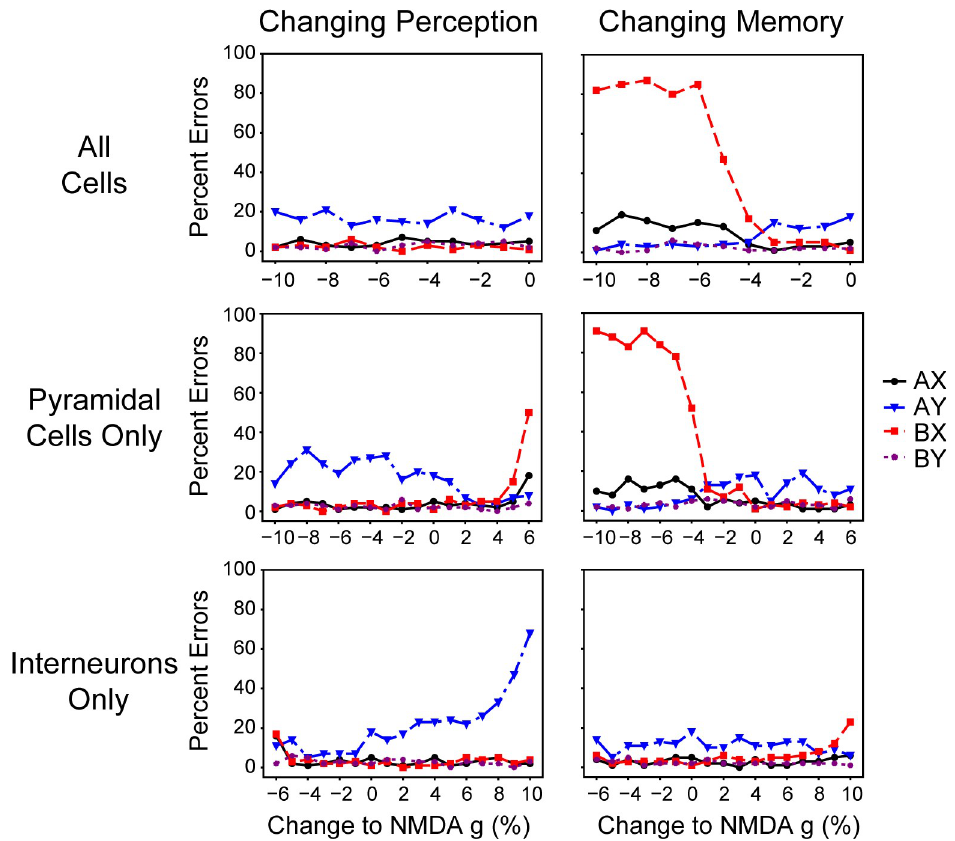
Fig 8. Specific network manipulations caused mistakes on various trial types. It is possible to determine whether the perception or memory network caused the agent to make an error by systematically altering the NMDA conductances of pyramidal cells and interneurons within either the perception or memory networks. Errors on AX and BX trials were most easily caused by the memory network when it began to have difficulty maintaining the representation of the cue during the ISI (middle and top right panels). Manipulations of the perception network also caused AX and BX errors (middle left panel), but this was due to it causing consequential changes in the memory network’s functioning (Fig 10). Errors on AY trials increased as the perception network became more inhibitory by either reducing pyramidal cell NMDA conductance or increasing interneuron NMDA conductance (middle and bottom left